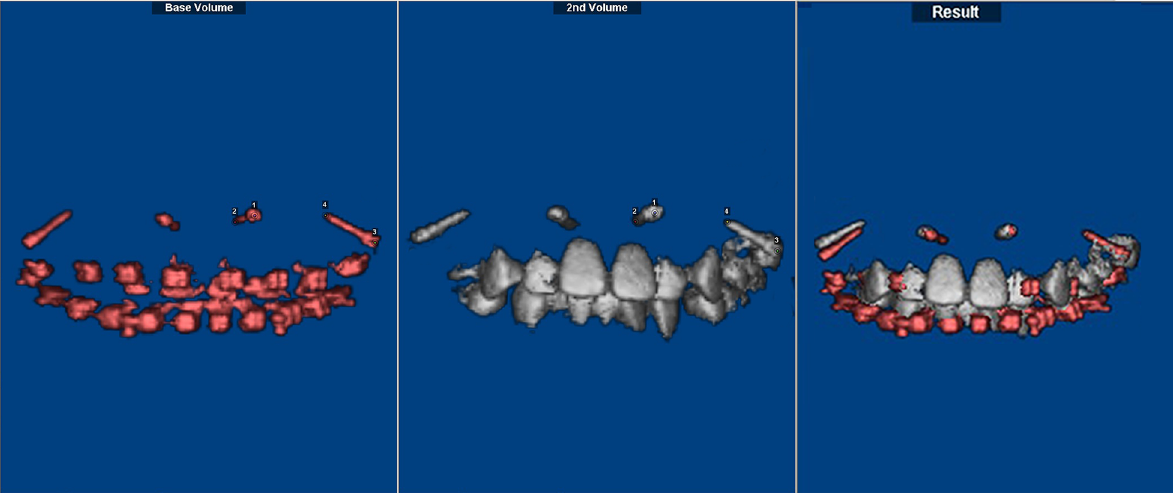
Fig 1. Implant superimposition for the adolescent sample. It was performed with the Dolphin software using the registration of four points: both endpoints of the two implants on the same side. Taking transverse palatal growth in adolescents into consideration, superimposition and measurement were processed on one side, and data from both sides were integrated.